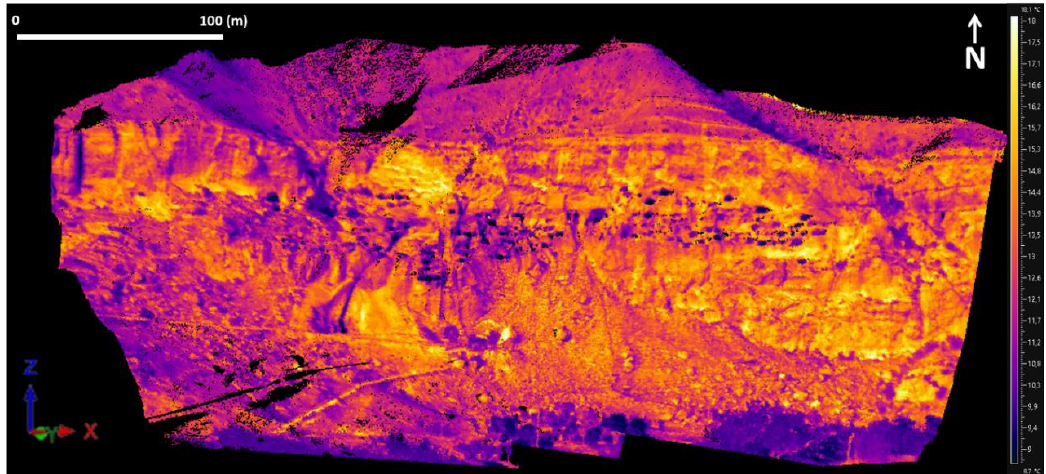
Figure 12. Mosaicked 3D surface temperature maps of the Vardzia monastery, obtained by merging the single thermograms with the UAV-DP slope surface.